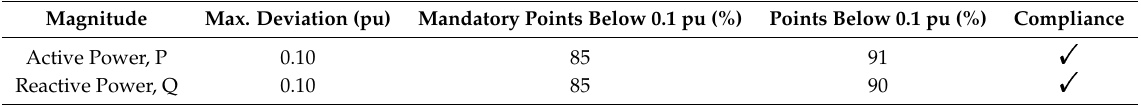
Table 4. Verification of the PVVC validation criteria applied to the detailed WT model at the testing point, operating at full load conditions: 20 kV, measurement point